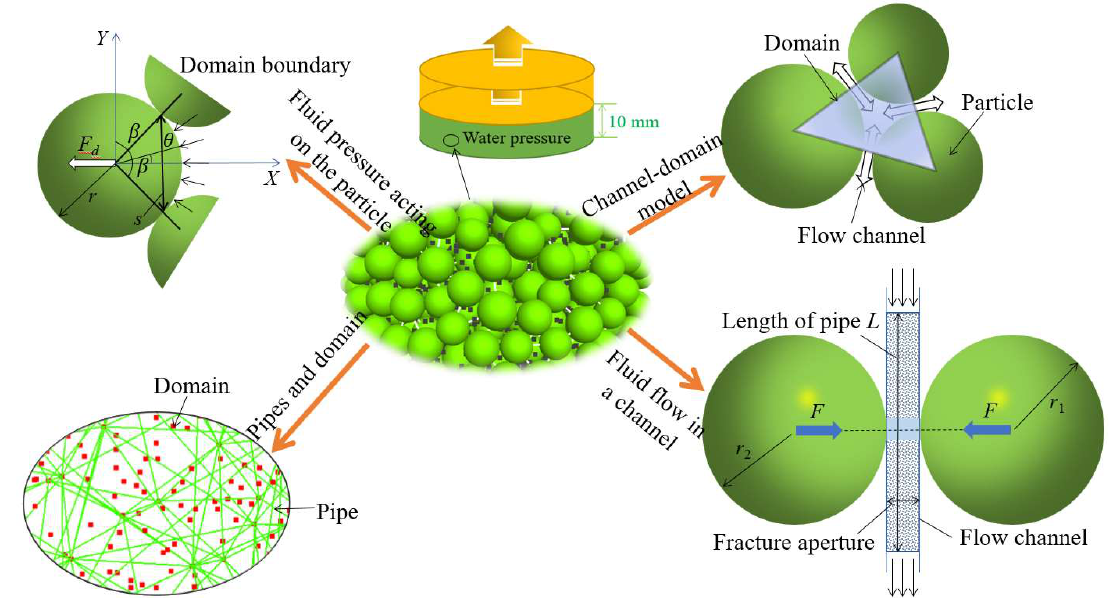
Figure 2. Schematic of incorporation of fluid coupling.